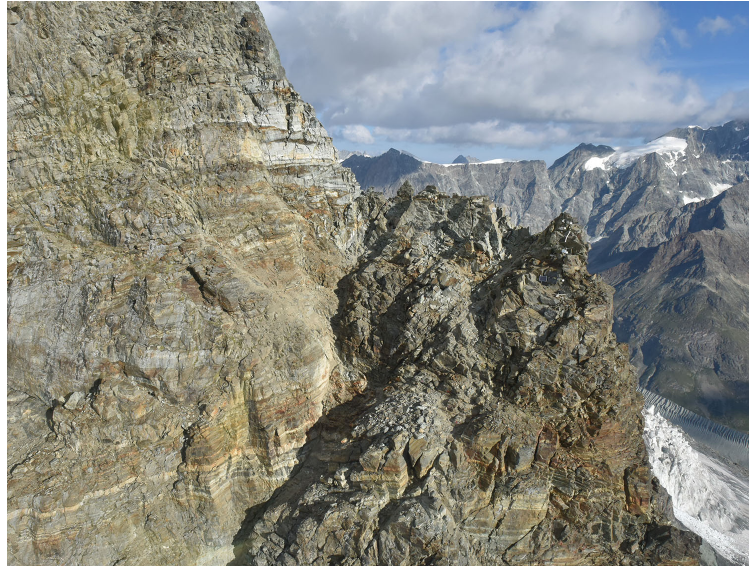
Figure C1. From the south the large detachment scar (light gray rock) to the left of the deeply incised second couloir on the Matterhorn Hörnligrat is clearly visible.